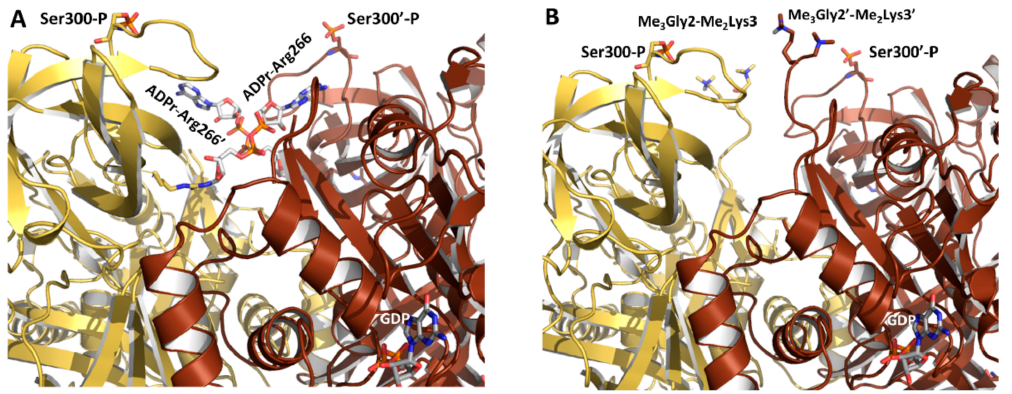
Figure 5. Theoretical models of ( A ) ADP-ribosylation on Arg266 and ( B ) N-terminal methylation on Gly2 and Lys3 of both monomers making up the eEF1A2 dimer, as present in the X-ray crystal structure [59]. Note the spatial proximity of both residues to Ser300 and Glu301, which also undergo other PTMs. The view is identical to that shown in Figure 3A. Ser300 is shown in a phosphorylated form (sticks) for reference purposes